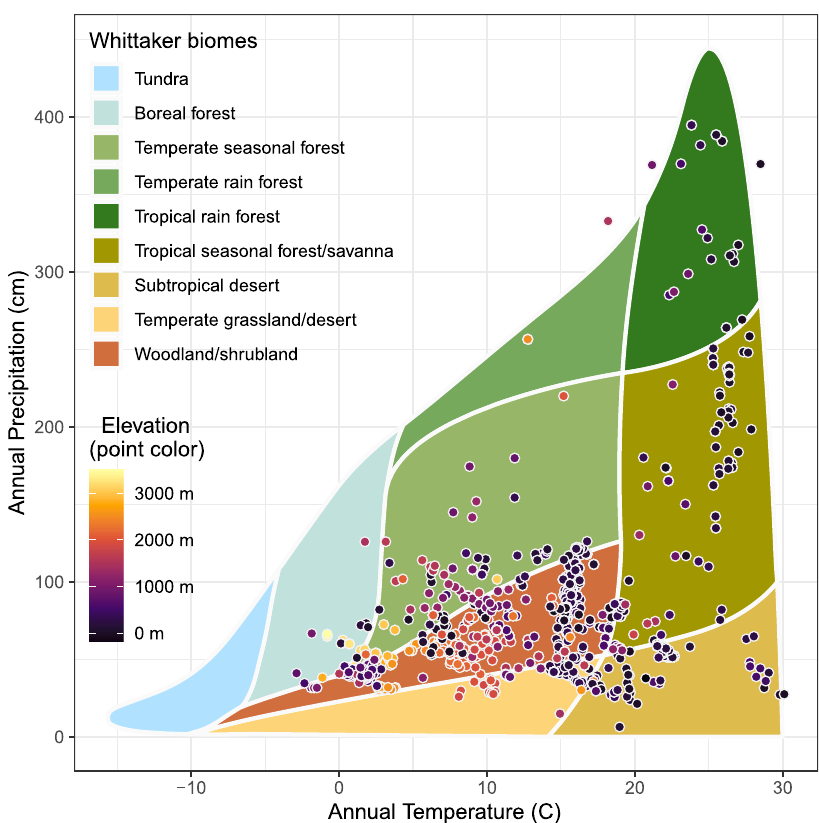
Fig. 2 Biomes of global tree mortality plots. Whittaker biome plot of database locations, showing the mean annual temperature (°C) and mean annual precipitation (cm) for all 1303 database plots. Each point represents a plot from the global database where climate-induced tree mortality happened. These mortality locations have occurred in all forested biomes, across a range of 30 °C of mean annual temperatures, and a four-meter annual precipitation gradient. Point color represents elevation, which ranged from sea level to 3488 m. Climate data for mean annual precipitation and mean annual temperature are taken from TerraClimate 33 and represent the average over 1970 – 2000. These data illustrate that whether a site is typically cool, warm, dry, or wet — eventually, a locally extreme hot drought can lead to tree